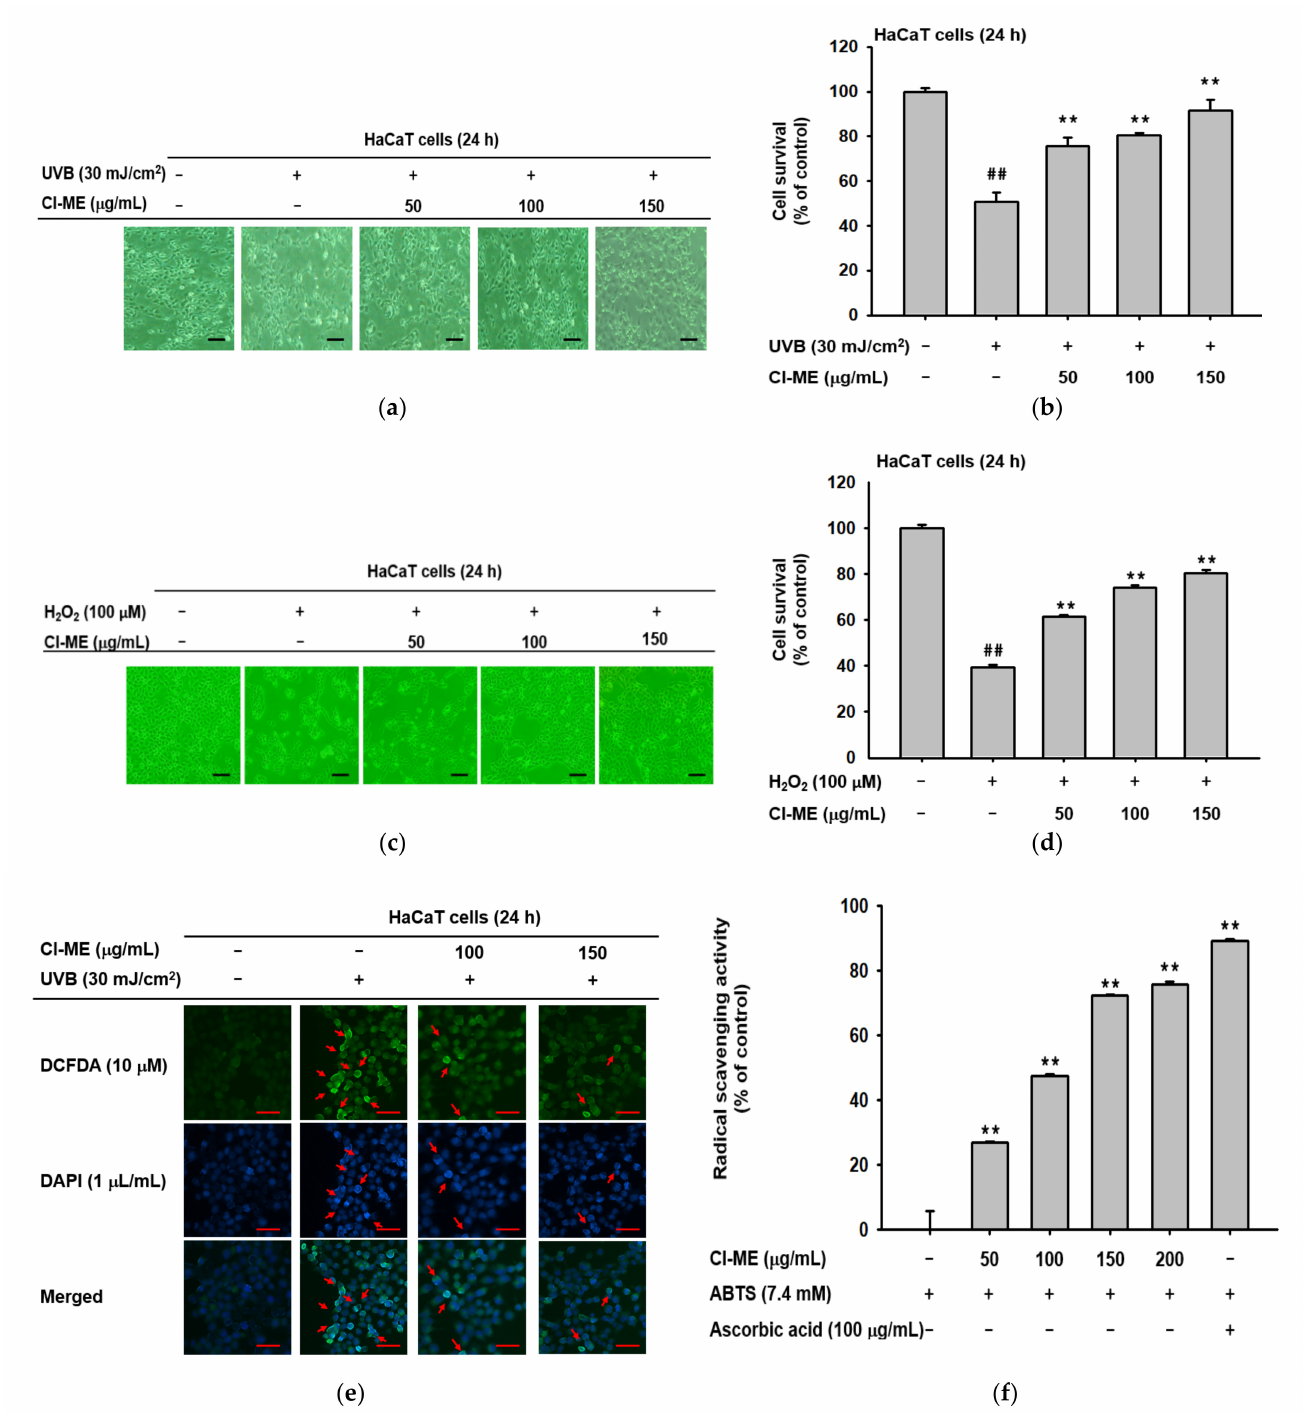
Figure 2. Antioxidant and photoprotective effects of Cl-ME on UVB- and H 2 O 2 -induced damage in HaCaT cells. ( a , c ) Morphological changes in UVB-treated (30 mJ/cm 2 ) HaCaT cells after 24 h treatment with Cl-ME (0–150 µ g/mL). ( b , d ) Survival (% of control) of UVB ( b )- or H 2 O 2 ( d )-treated HaCaT cells after a 24 h treatment with Cl-ME. ( e ) Protective activity of Cl-ME against ROS and cell damage as measured through DCFDA (10 µ M) and DAPI (1 µ L/mL) staining in HaCaT cells after 24 h of treatment. ( f ) Radical scavenging activity of Cl-ME was measured using the ABTS assay with ascorbic acid as the positive control. ## p < 0.01 compared to the normal group and ** p < 0.01 compared to the control